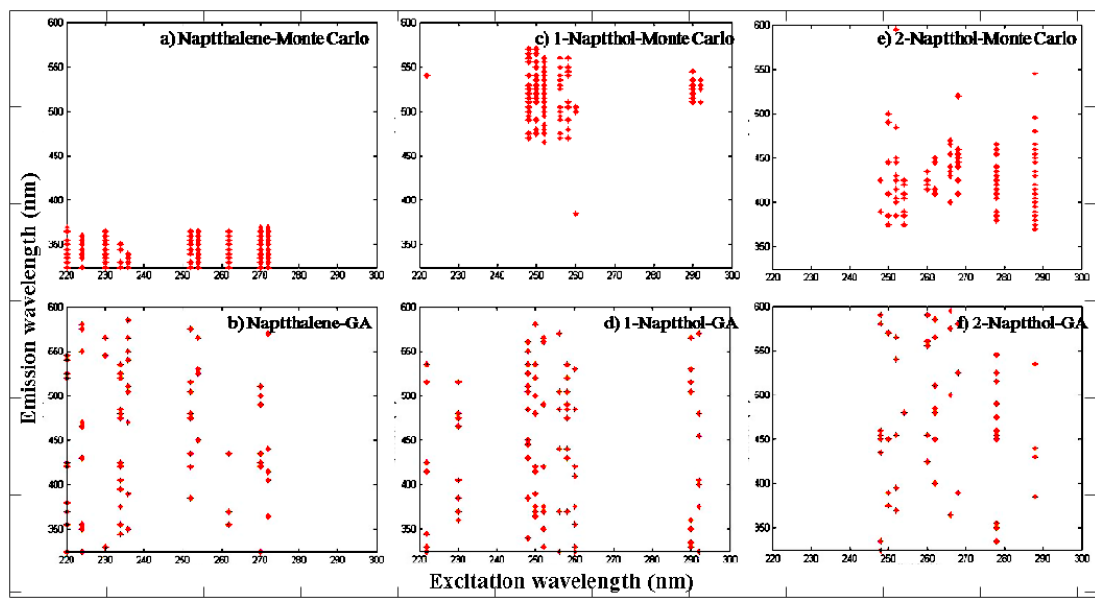
Figure 3. Selected emission wavelengths of the three components. The dots in ( a , c , e ) are the selected wavelengths by the Monte Carlo method. The dots in ( b , d , f ) are the selected wavelengths by the GA (genetic algorithm) method.